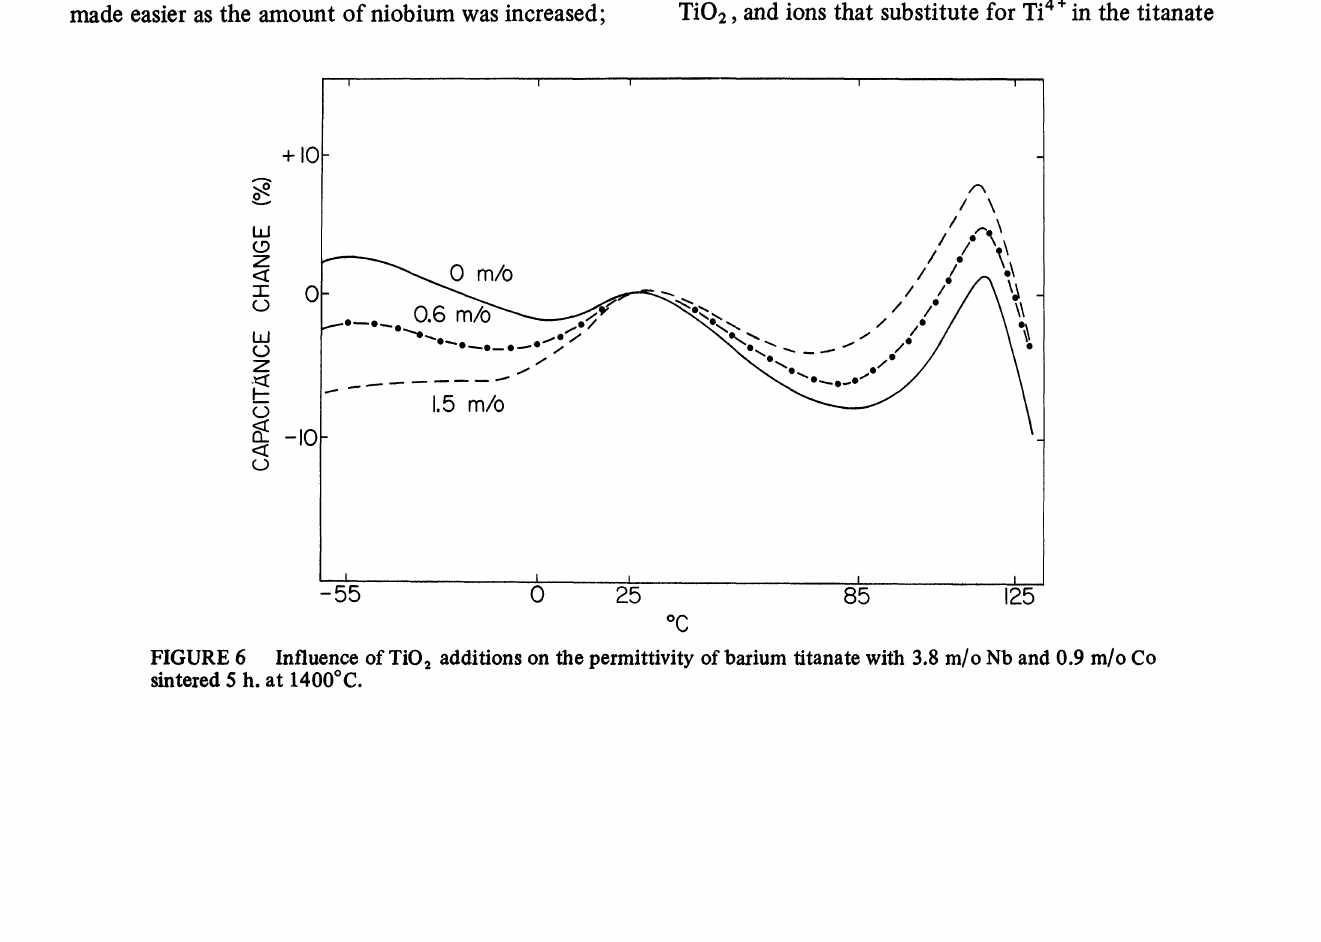
Influence of TiO2 additions on the permittivity of barium titanate with 3.8 m/o Nb and 0.9 m/o Co sintered 5 h. at